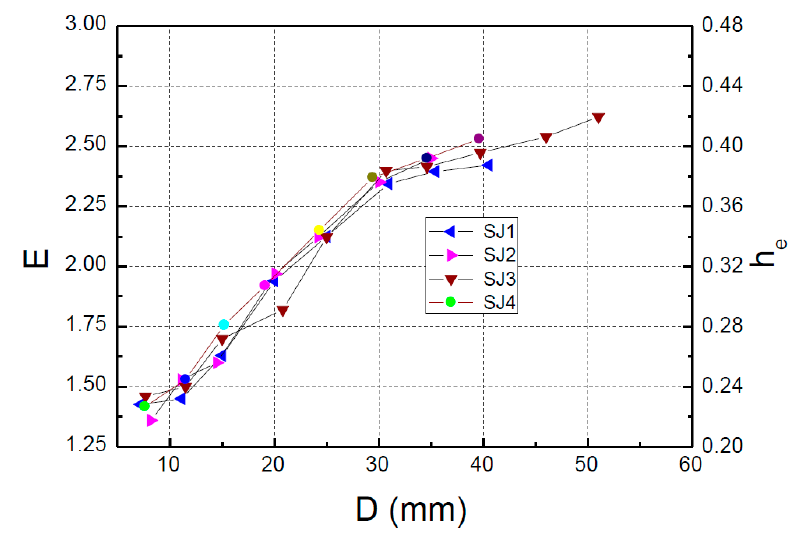
Figure 13. E-D (h e -D) curves.